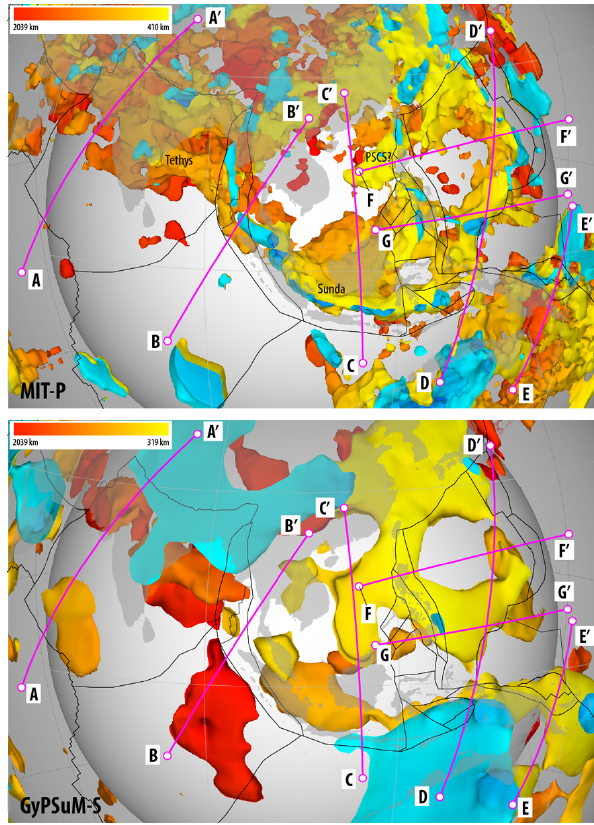
Fig. 9. 3-D visualization of + 0.2% seismic velocity anomaly iso- surfaces in MIT-P (top) and + 0.9% seismic velocity perturbation in GyPSuM-S (bottom) models. Profiles A to G represent the vertical profiles (see Fig. 10) that capture the convergence and subduction histories of the region since the Cretaceous. Present-day coastlines are translucent grey shades, and present-day plate boundaries are translucent black lines. Slab volumes are colored by their depth, while the light blue color represents the interior surface of these slabs. PSCS–proto-South China Sea